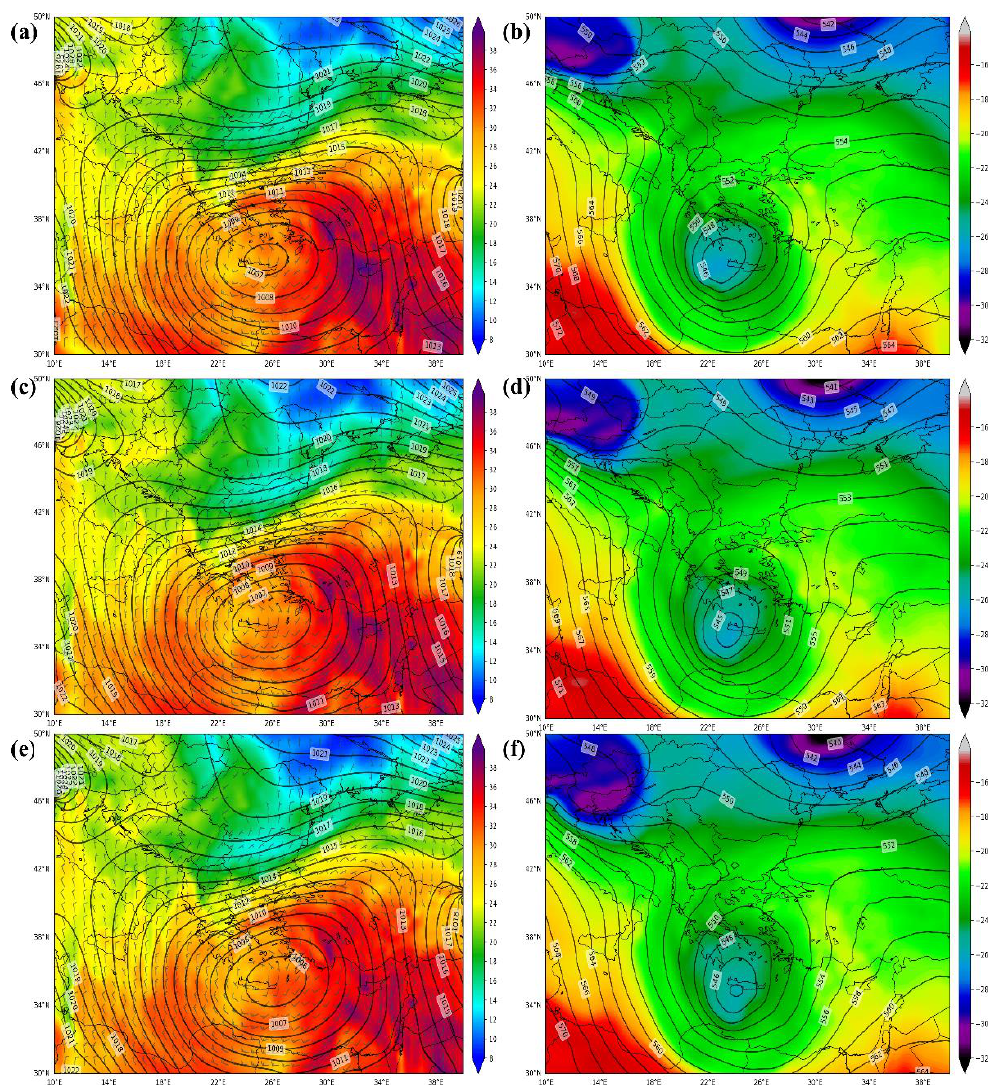
Figure 9. As in Figure 2 but for 10 December 2009, 2200 UTC ( a , b ), 11 December 2009, 0000 UTC ( c , d ), and 11 December 2009, 0200 UTC ( e , f ).